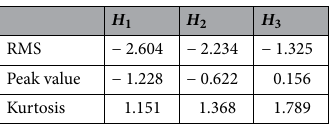
Table 1. Indicator evaluation level and reference value.